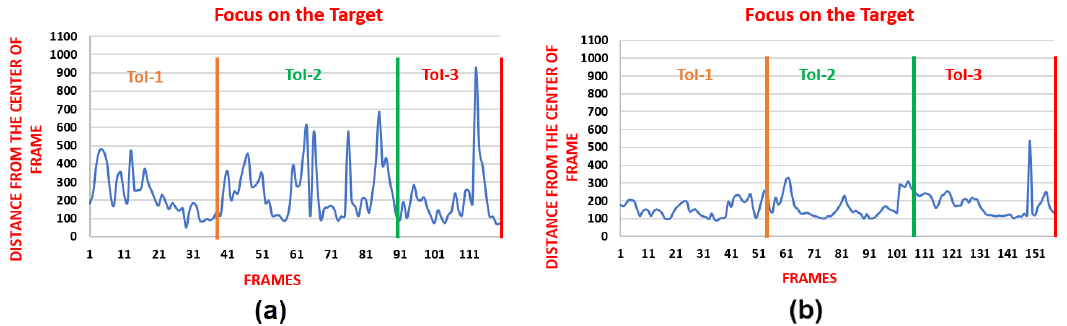
Figure 9. Experiment 2 focus precision (pixels) for variation 1 ( a ) RC, ( b )